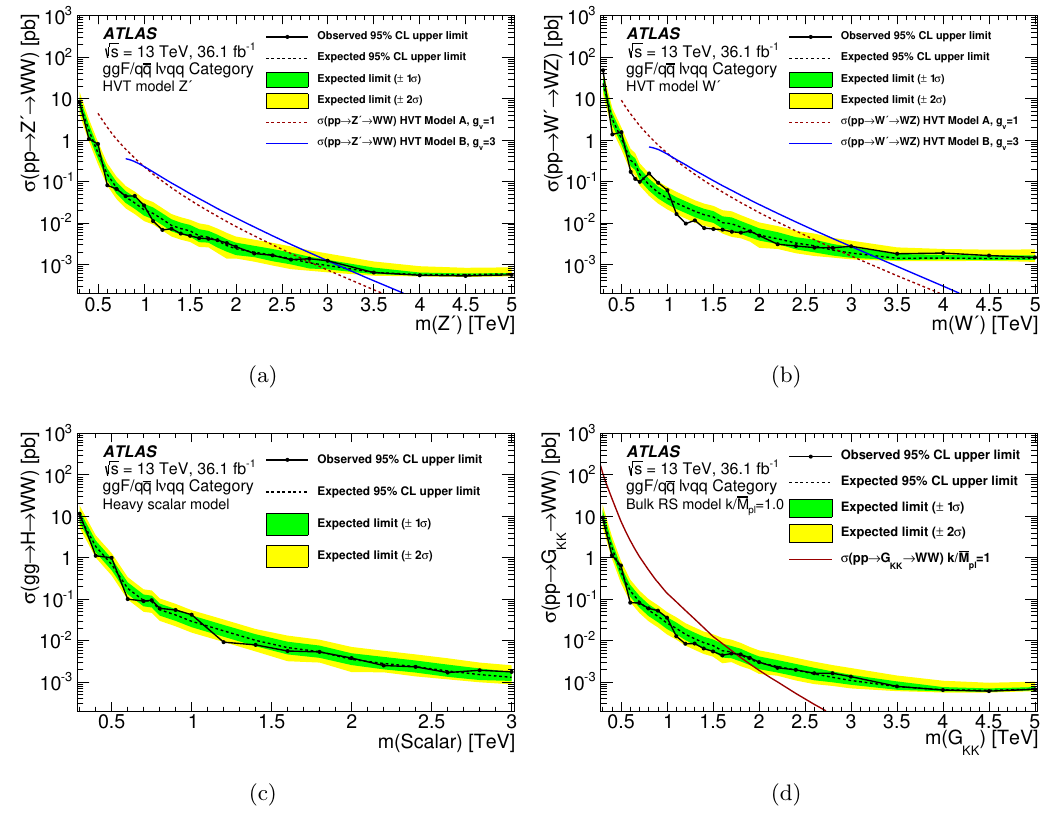
Figure 7 . The observed and expected cross-section upper limits at the 95% con(cid:12)dence level for WV production in the ggF = q(cid:22)q category are presented as a function of the resonance mass. Interpretations for (a) HVT WW , (a) HVT WZ , (c) scalar H ! WW and (d) G KK produced via gluon-gluon fusion or quark-antiquark annihilation are presented. The red and blue curves, where available, show the predicted signal cross section as a function of resonance